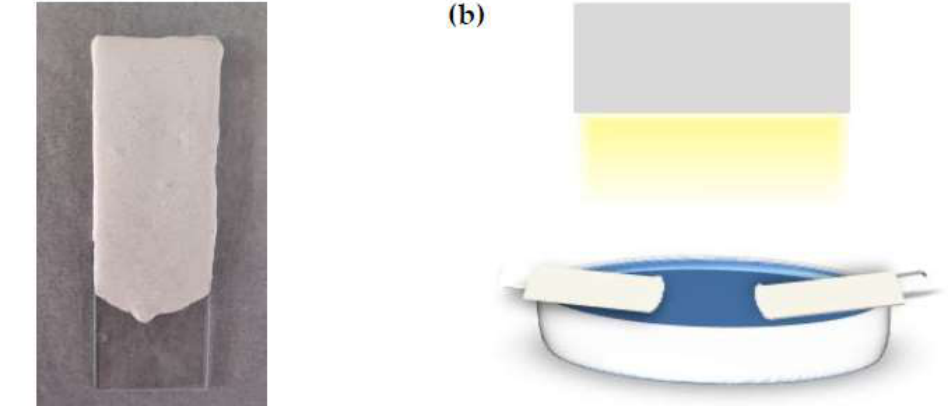
Figure 1. The concrete specimens samples after cured 28 days ( a ) and photocatalytic experiment setup ( b ) .